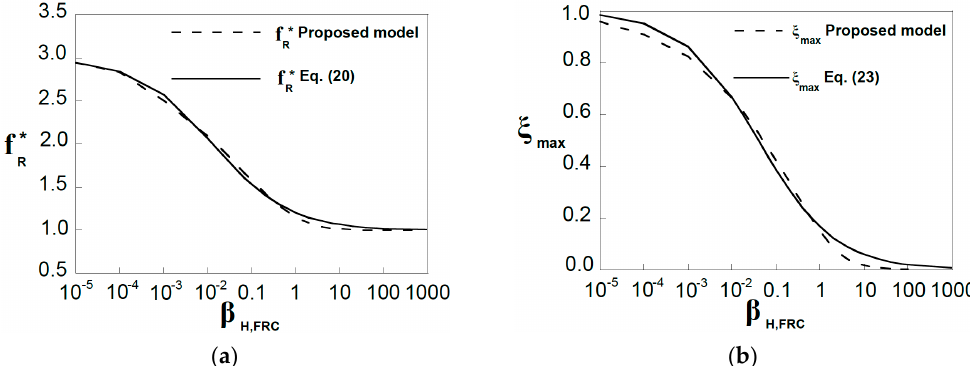
Figure 10. Planar crack model results for the non-dimensional flexural strength, f R * , and correspond- ing crack-depth, ξ max , fitted by ( a ) f R * given by Equation (20), and ( b ) ξ max given by Equation (22), respectively.